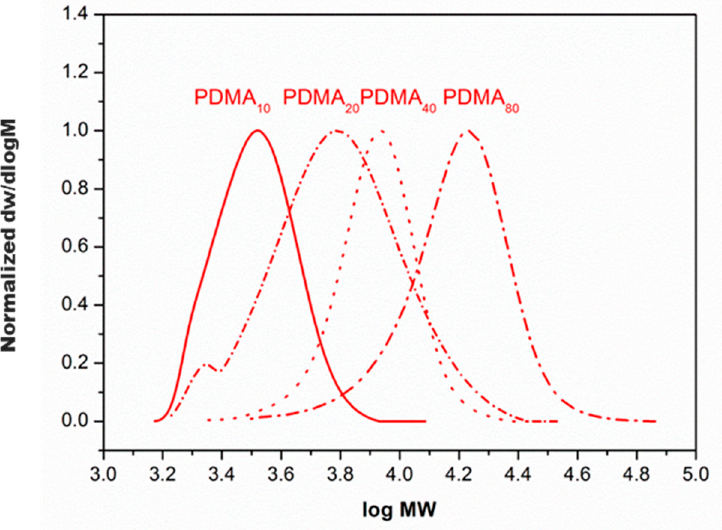
Figure 1. The evolution of molecular weights of PDMA (DP = 10–80) catalyzed by the generated Cu(0) particles/CuBr 2 /Me 6 TREN complex in water determined by gel permeation chromatography (GPC) using dimethylformamide (DMF) as the mobile phase.